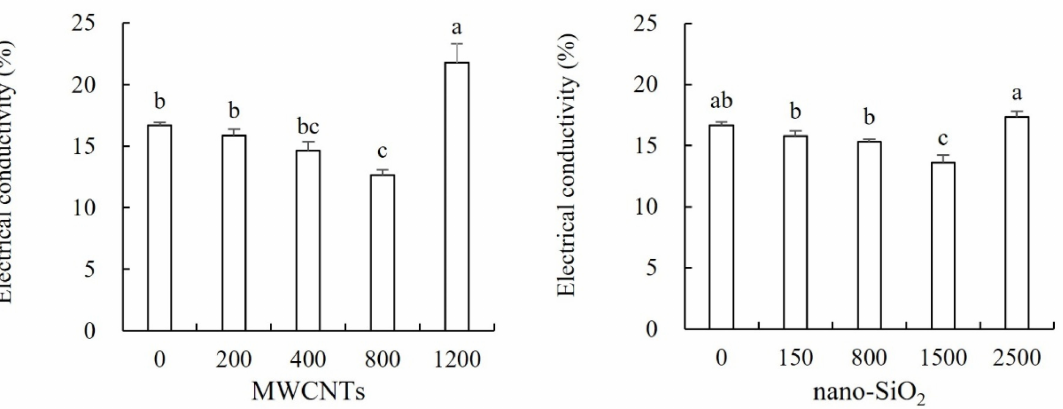
Figure 3. Effect of different concentrations of MWCNTs and nano-SiO 2 on electrical conductivity in maize. Note: Data are expressed as mean ± standard deviation. Different letters within the same column indicate significant difference at 5%